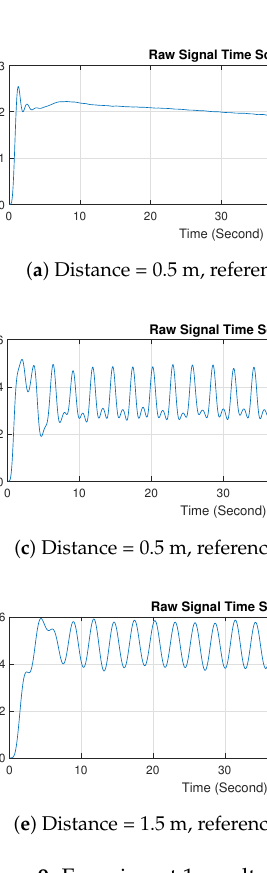
Figure 9. Experiment 1 results in time domain. Figure 10 shows the measurement results in the frequency domain. Multiple frequen- cies shown in the figures were caused by some disturbances (e.g., signal clutters), so the signal was not a pure sinusoid. A pure sinusoidal signal results in a single spectral peak. Therefore, in practice, we indicate the frequency at which the highest spectral peak occurs as the breathing rate. For example, in Figure 10c, the peak occurred at a frequency of 0.3603 Hz. The designed radar was able to accurately detect the breathing rates, even when the radar was 2 m away from the